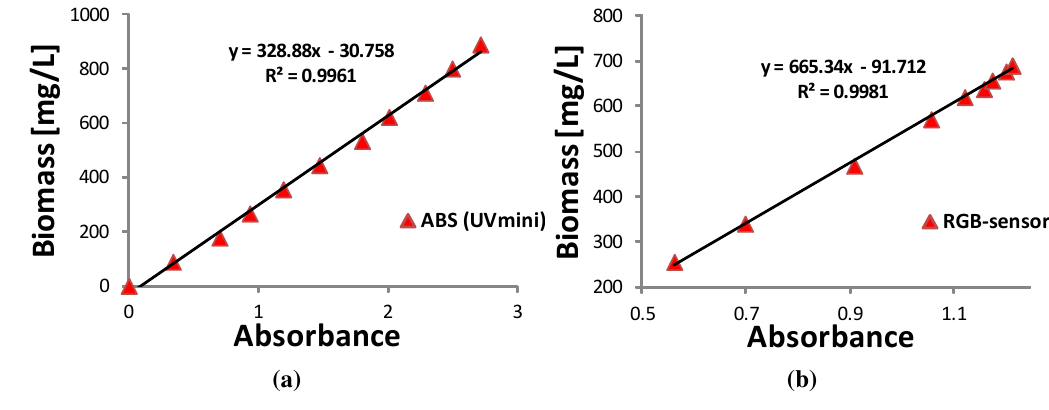
Figure 4. Calibration for the microalgal culture Dunaliella tertiolecta . ( a ) Relationship between biomass concentration and absorbance obtained from the spectrophotometer UVmini at 680 nm by 10 dilutions; ( b ) Relationship between biomass concentration and absorbance obtained online from the RGB sensor during the exponential